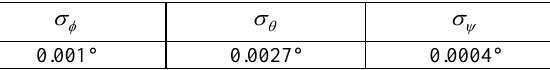
Table 9: Standard deviations of the boresight angles estimated with the simulated data